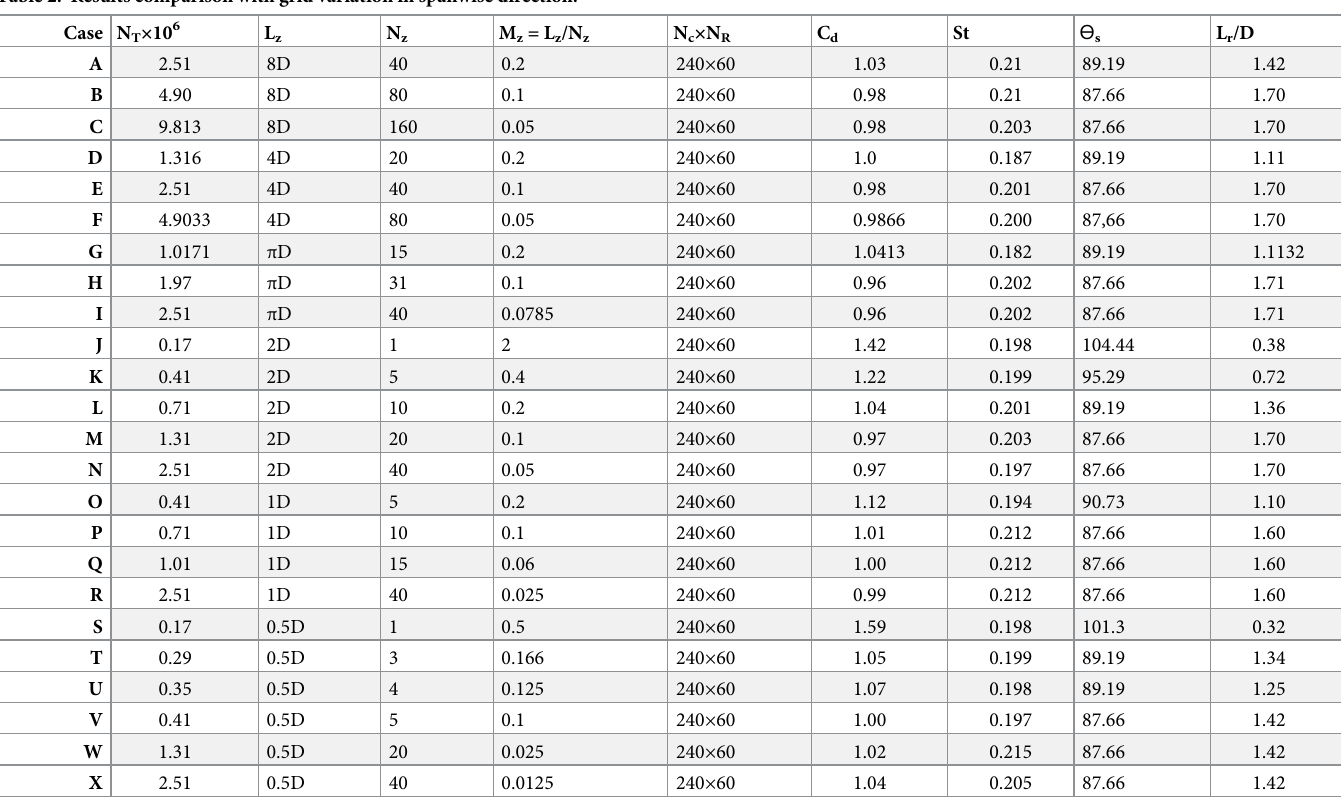
Table 2. Results comparison with grid variation in spanwise